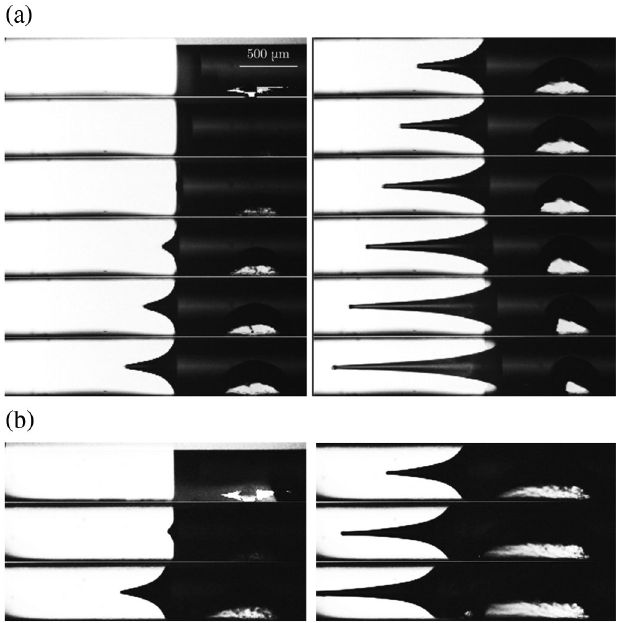
FIG. 3. Bubble growth and jet evolution after focusing the laser on the axis of a 500 - (cid:1) m capillary tube with (a) E ¼ 365 (cid:1) J and H ¼ 600 (cid:1) m and (b) E ¼ 650 (cid:1) J and H ¼ 600 (cid:1) m . The first image shows the tube at the moment the laser is fired. The subsequent images are taken 7 (cid:1) s apart. (See Ref. [31] for the related